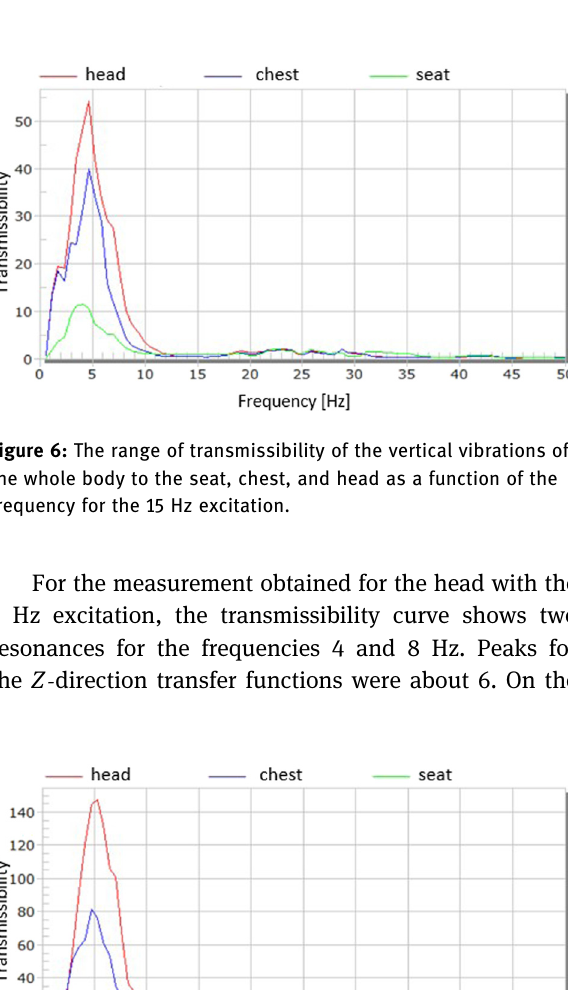
Figure 3: The range of transmissibility of the vertical vibrations of the whole body to the seat, chest, and head as a function of the frequency for the 2 Hz excitation.